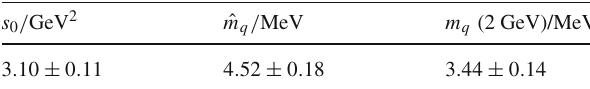
Table 2 Results from the Monte-Carlo based QCD sum rules: s 0 , ˆ m q and the scale-dependence light quark masses m q . A conservative Borel window 0 . 37 GeV − 2 < τ < 1 . 05 GeV − 2 is taken here. See the text for details. The statistical uncertainties are contributed by the OPE conden- sates, the instanton size ρ , the parameter κ and the spectral functions of Ref. [24], i.e., the shaded areas shown in Fig.